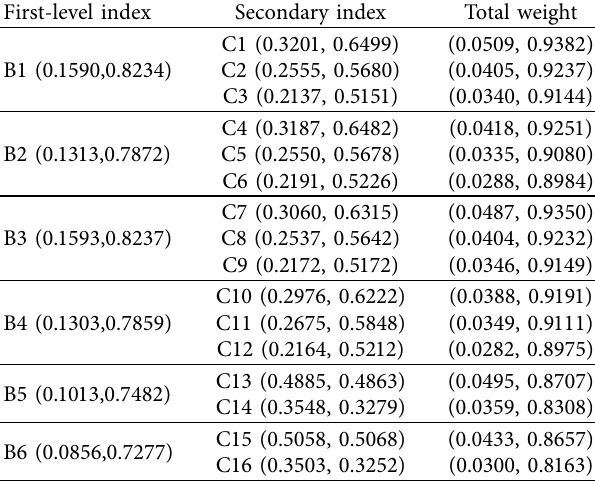
Table 3: Weight of each index and total weight.